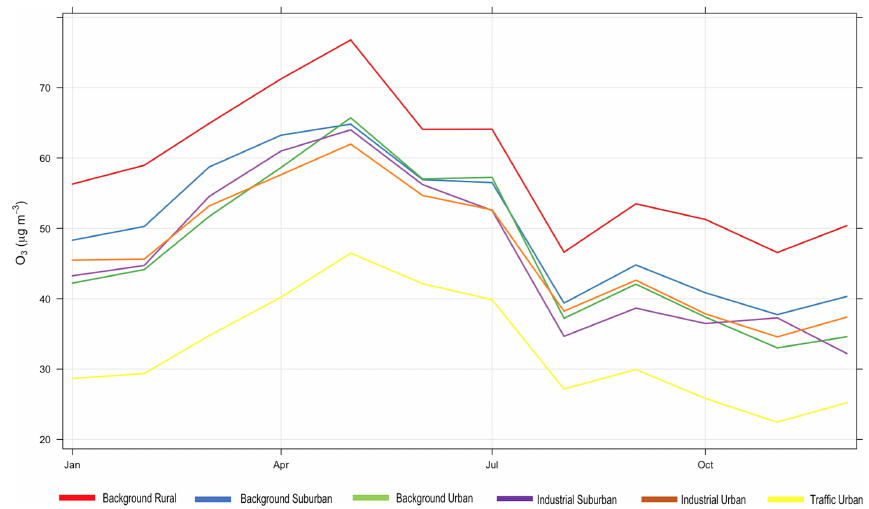
Figure 6. Monthly average concentrations of observed O 3 for each environmental type for the year 2018.